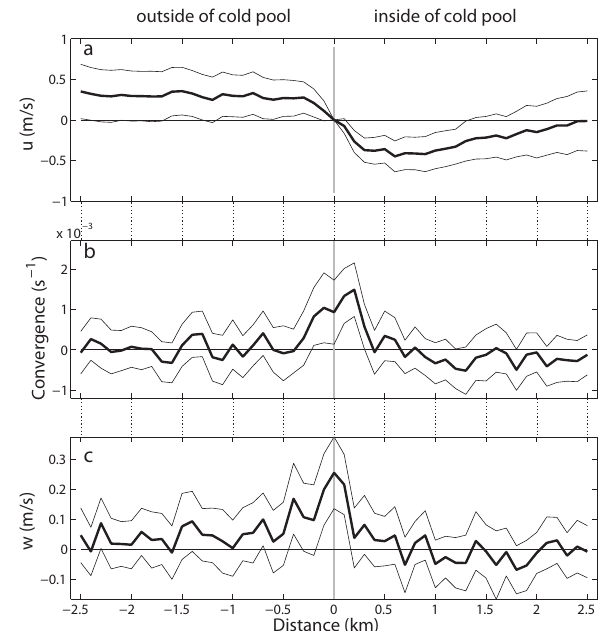
Fig. 11. Composite thermodynamic measurements of (a) potential temperature ( θ ), (b) water vapor mixing ratio ( q v ), and (c) equiva- lent potential temperature ( θ e ) from 90 cold-pool edges. Anomalies relative to the value at the cold-pool edge are plotted. The air mass within the cold pool is found to the right of zero, while air mass outside of the cold-pool air mass is found to the left of zero. Bold lines indicate mean values, while thinner lines indicate the 95% confidence intervals of the mean, calculated using a standard Stu- dent t test. The gray line in (b) indicates the change in q v based on observed θ in the case where c p 1θ = − L1q v .